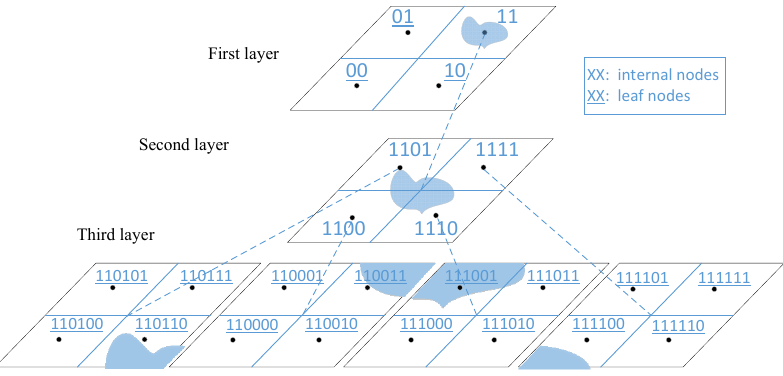
Figure 1. Structure of quad-tree with maximum layer depth 3.